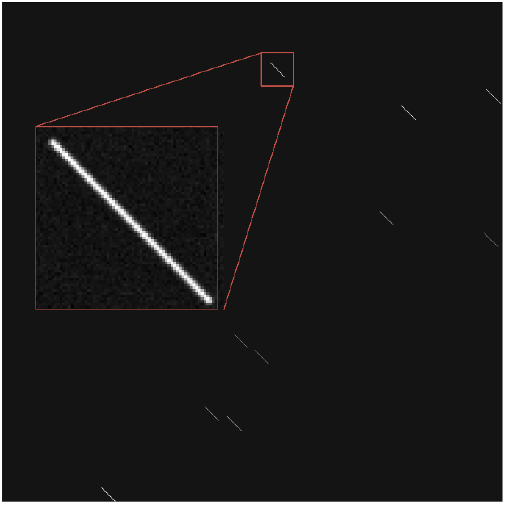
Figure 8. A star image with a trailing trail in rolling shutter exposure mode.